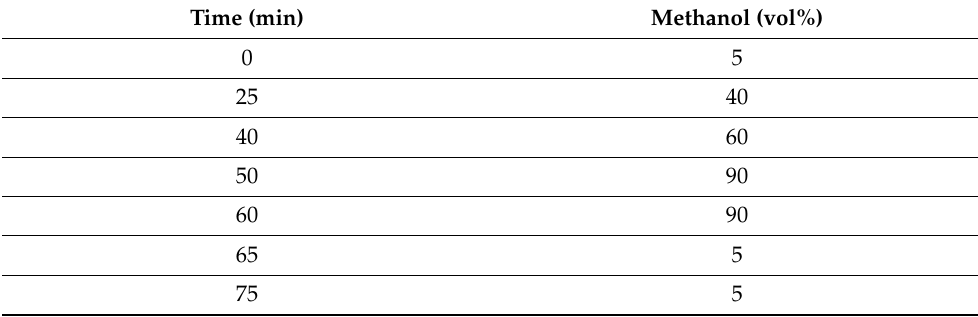
Table 1. Time course of methanol gradient for HPLC-UV analysis.